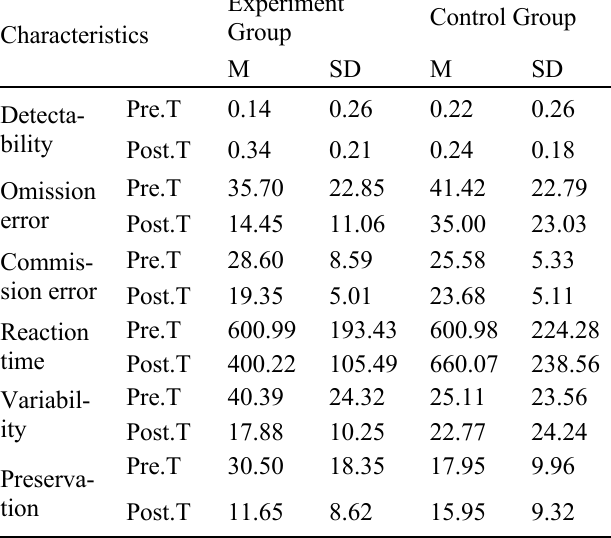
Table 1. The mean and standard deviation of Attention Deficit Hyperactivity Disorder components in pretest and posttest of Conner's Parent Rating Scale.